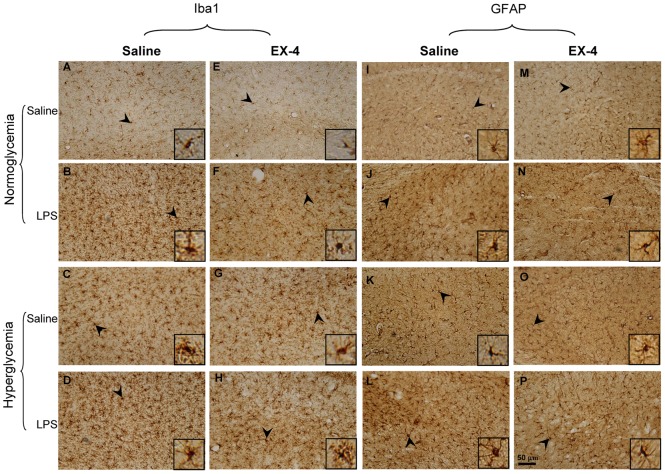
Immunohistochemical analysis of microglia and astrocytes in the mouse hippocampus.(A–H) Representative immunostainings of microglia by Iba1 antibody in the mouse hippocampus. (I–P) Representative immunostainings of astrocytes by GFAP antibody in the mouse hippocampus. Scale bar = 50 µm. Arrowheads indicated positive staining for activated microglia and astrocytes, which are magnified in the insets of each figure (n = 3–5 per group).